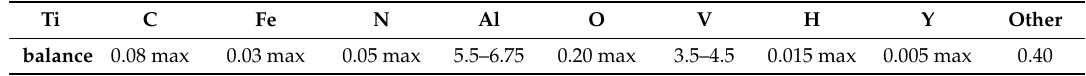
Table 1. Chemical composition of Titanium grade 5 (weight